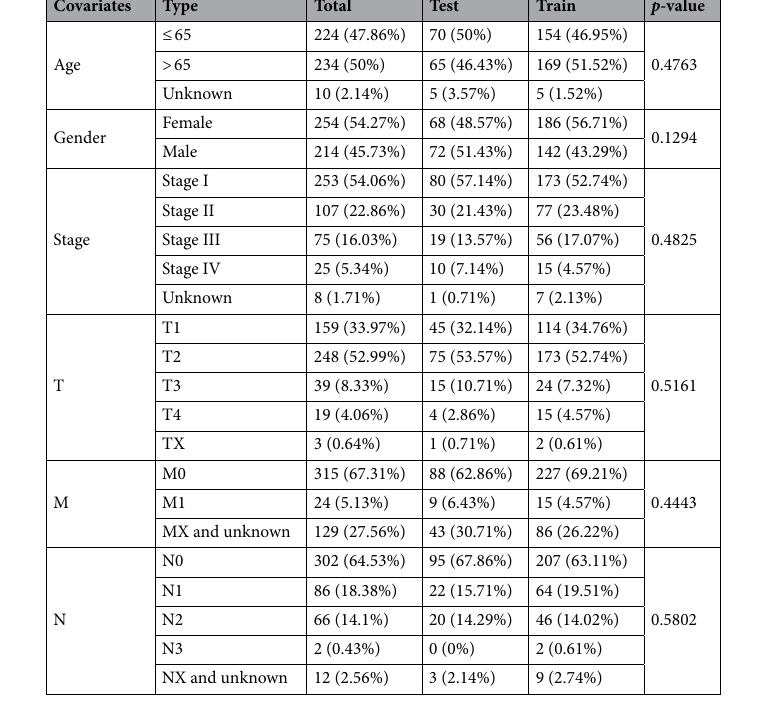
Table 3. Comparison of TCGA training and testing cohorts.